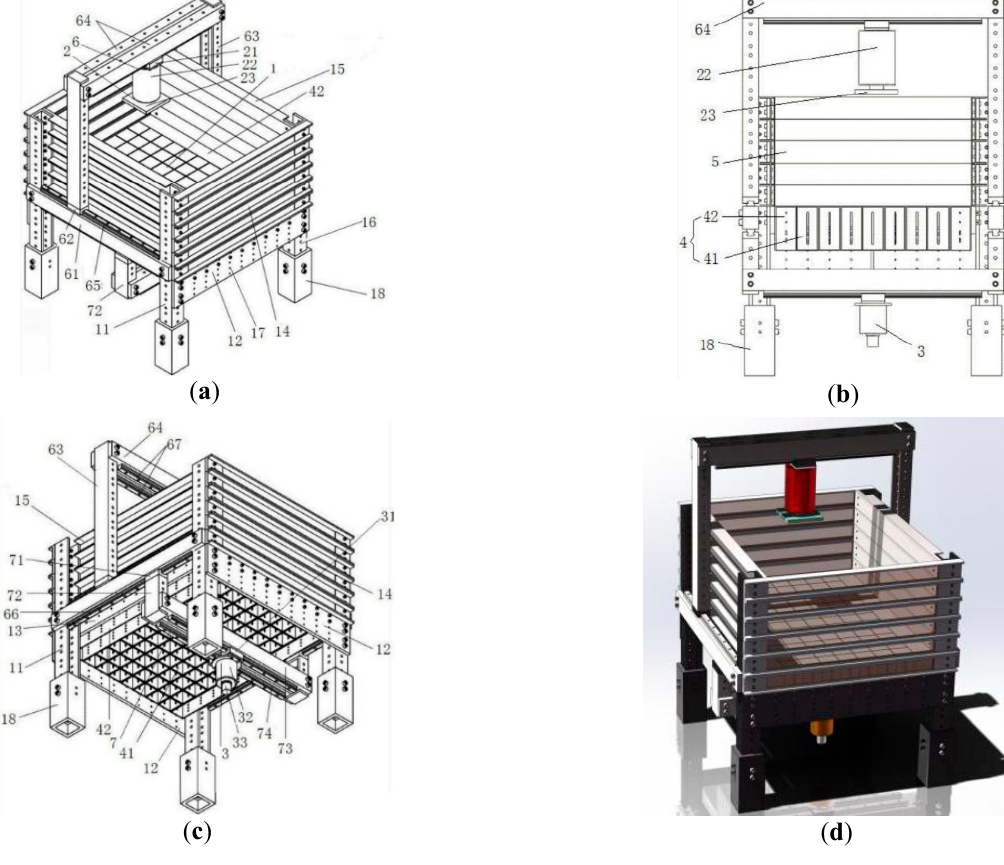
Figure 3. Structure diagram of the test device. The numbers in the diagrams can be described as follows: 1—outer frame, 11—column, 12—the first pressure plate, 13—the second pressure plate, 14—the first baffle, 15—second baffle, 16—threaded hole, 17—the first threaded hole, 18—bearing, 19—transparent acrylic plate, 2—pressurization unit, 21—the first ball slide, 22—hydraulic jack, 23—loading plate, 3—pulling unit, 31—third ball slide, 32—drawing instrument, 33—pull rod, 4—coal seam simulation part, 41—mining coal block, 42—reserved coal pillar assembly, 5—similar materials for coal rock formations, 6—pressurizing position adjustment unit, 61—central rail beam, 62—second ball slide, 63—upper track column, 64—upper rail beam, 65—upper slide, 66—lower slide, 67—first slide, 7—pulling position adjustment unit, 71—fourth ball slide, 72—lower track post, 73—lower track beam, 74—second slide. ( a ) direction view 1 ( b ) left view ( c ) direction view 2 ( d ) 3D